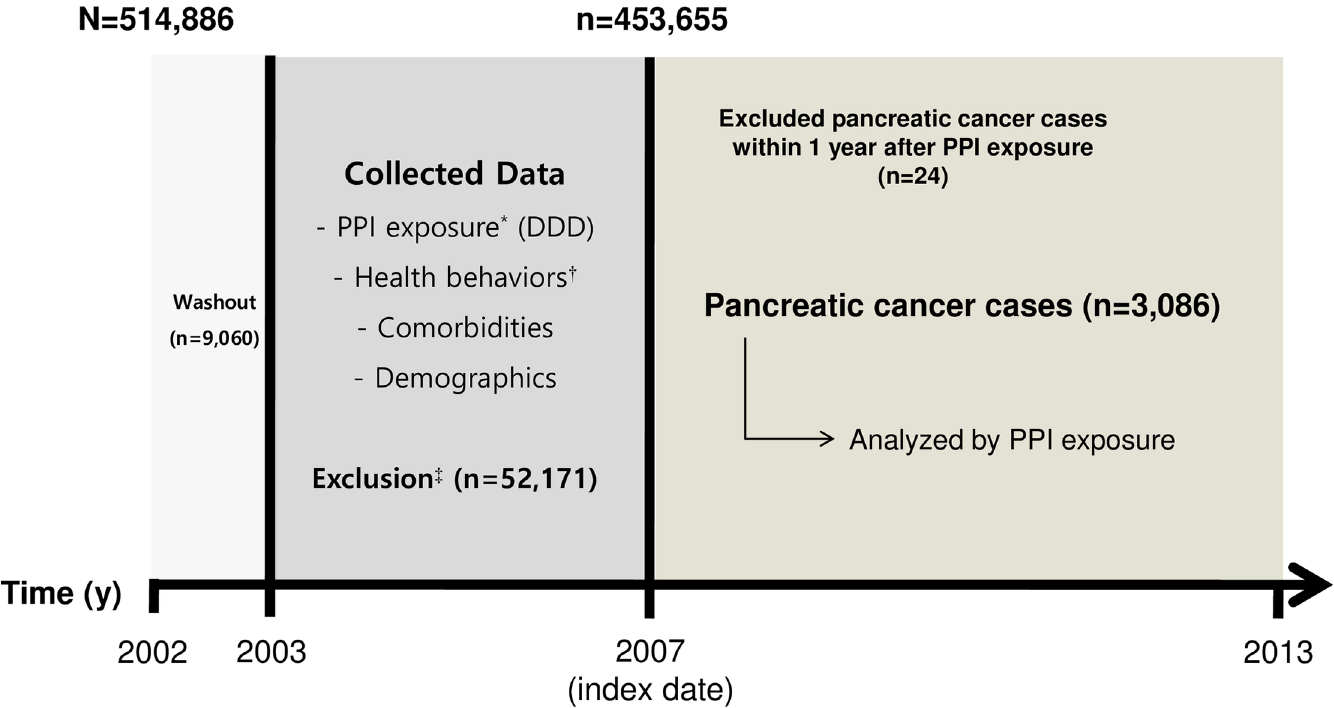
Fig 1. Study design and participant recruitment. DDD, Defined Daily Dose; PPI, proton pump inhibitor; NHIC, National Health Insurance Corporation. (cid:3) Using the NHIC claims database. † From national health examinations including body mass index, smoking status, drinking habits, and physical activity. ‡ Patients with any cancer diagnosis by ICD-10 “C” code, with past medical history of cancer according to health check survey data, who died before the index date, or had missing non-survey health check-up variables were excluded from study. The exocrine type occupied the majority of pancreatic cancer cases (98.3%).